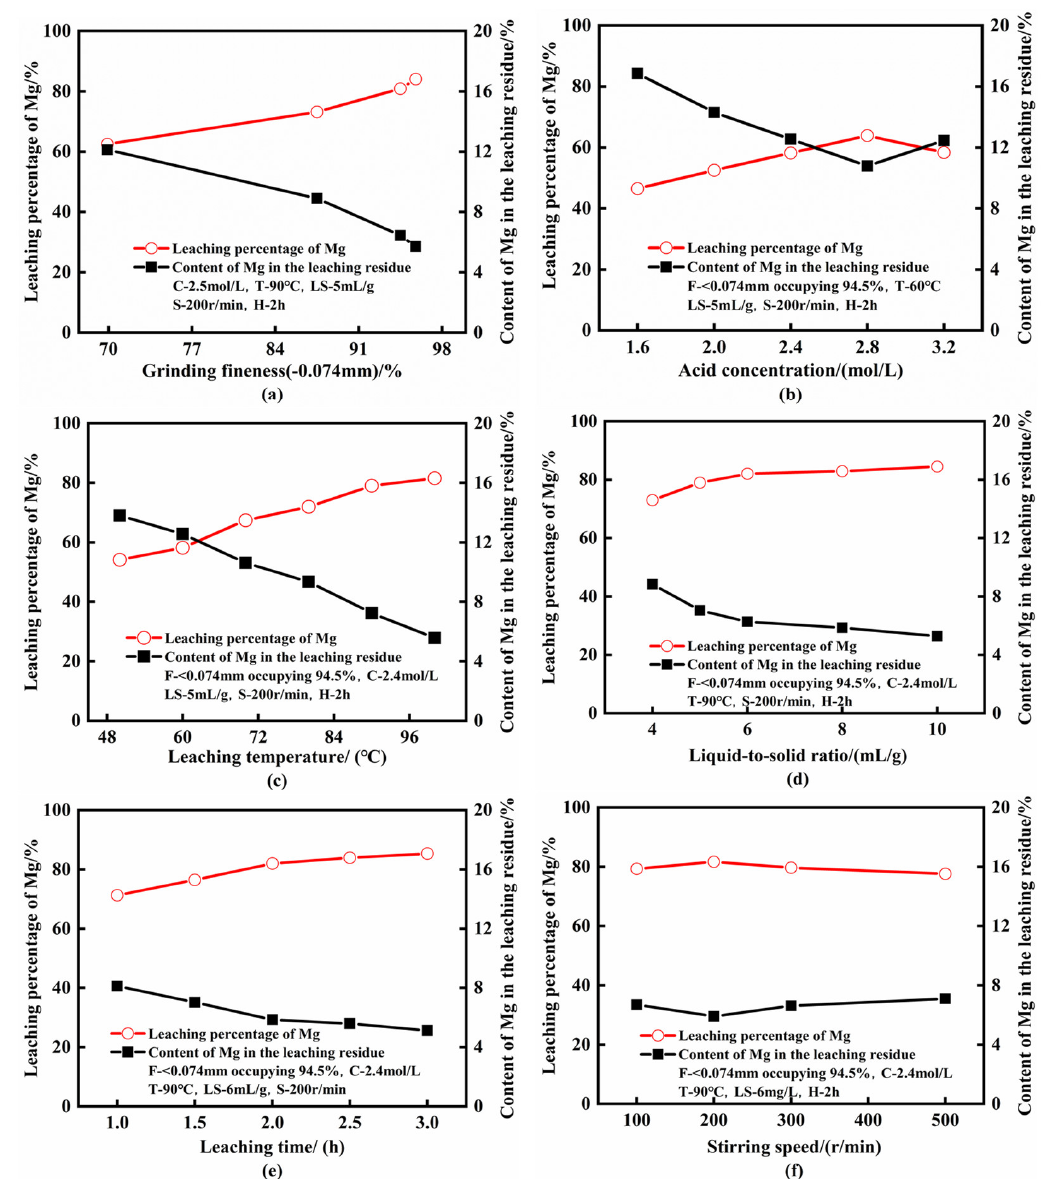
Figure 3. Effect of variables on the efficiency of leaching magnesium from ferronickel slag ( a ) grinding fineness; ( b ) acid concentration; ( c ) leaching temperature; ( d ) liquid-to-solid ration; ( e ) leaching time; ( f ) stirring speed. (F—grinding fineness; C—acid concentration; T—leaching temperature; LS—liquid-to-solid ratio; H—leaching time; S—stirring speed).